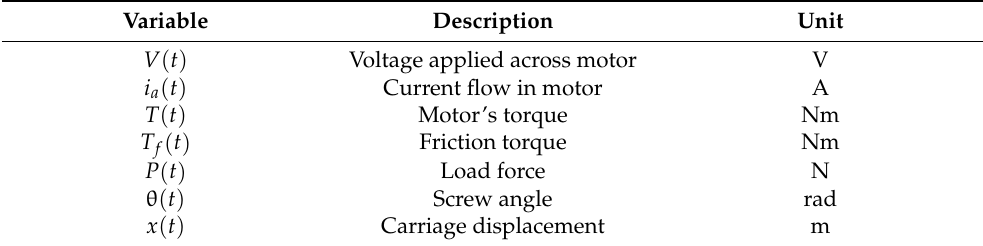
Table 1. State variables in the electro-mechanical linear stage.